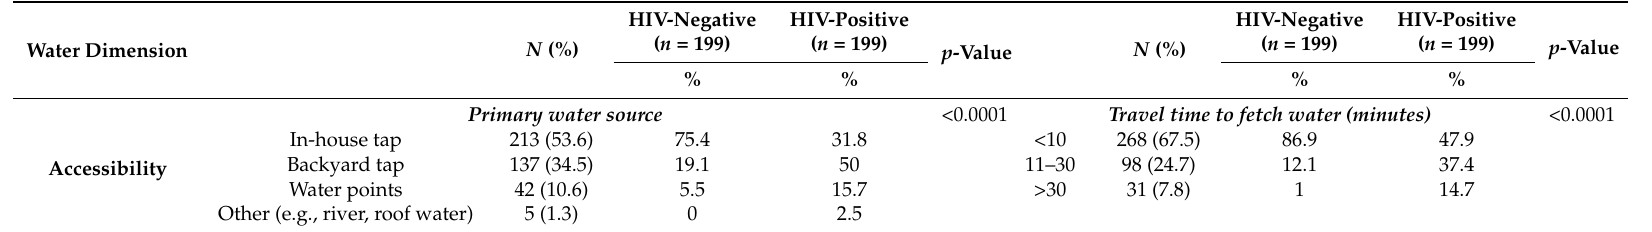
Table 2. A comparison of water access among the HIV-negative and HIV-positive groups in Wukro ( N = 398).